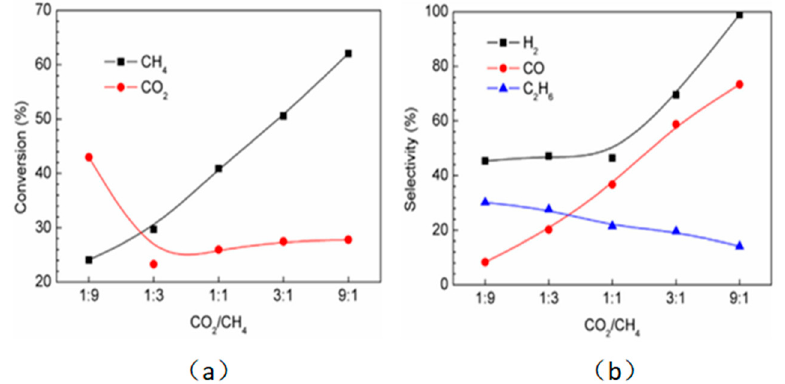
Figure 8. The CO 2 /CH 4 molar ratio effect on the catalytic performances of plasma dry reforming of methane (DRM) reaction: ( a ) Conversion; ( b ) selectivity. (Total feed flow 25 mL min − 1 , discharge power 15 W). Reproduced with permission from [27], Copyright 2015, Elsevier.